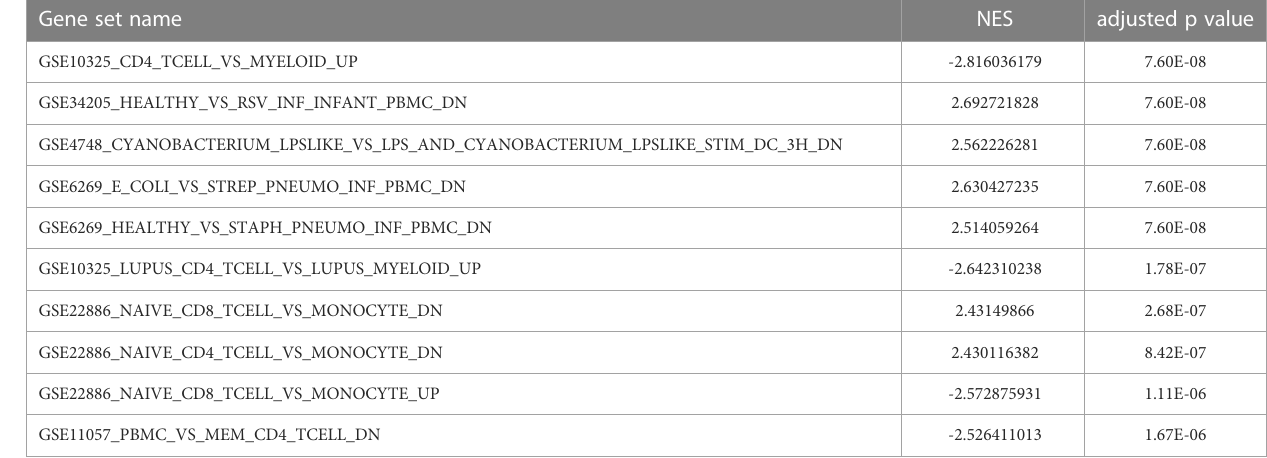
TABLE 2 Top 15 signi fi cant immunological signatures enriched by immunity in GSEA of